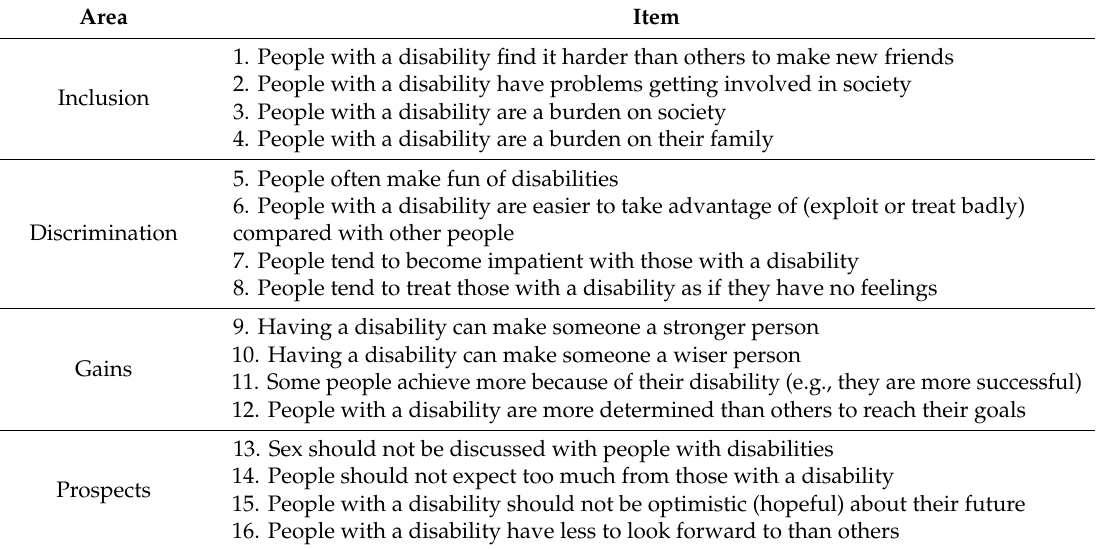
Table A1. Attitudes to Disability Scale (ADS) developed by WHOQOL Group [18].